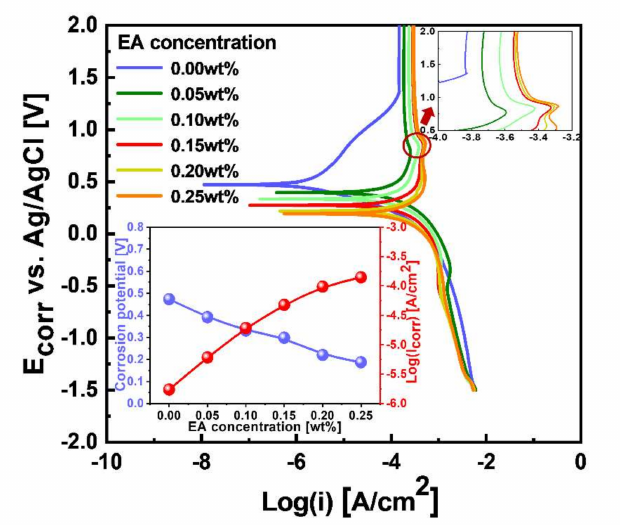
Figure 5. Potentiodynamic polarization curves of the W-film surface depending on the scavenger (i.e., EA) concentration after dipping the W-film surface into the W-film surface slurries. The upper inset represents the chemical oxidation magnitude on the W-film surface. The lower inset indicates dependencies of corrosion potential (i.e., E corr ) and corrosion current (i.e., I corr ) depending on the scavenger (i.e., EA)